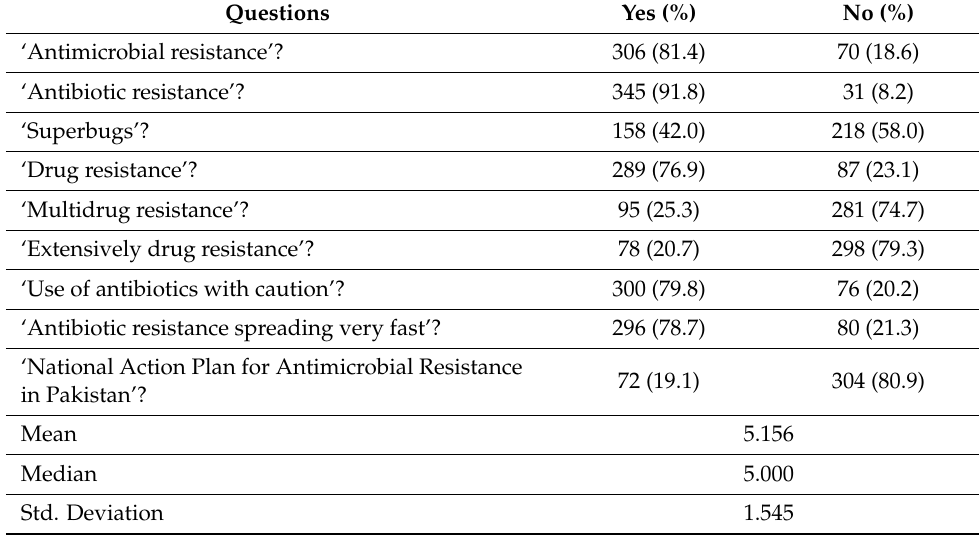
Table 4. Awareness about the terminologies related to antibiotic resistance.